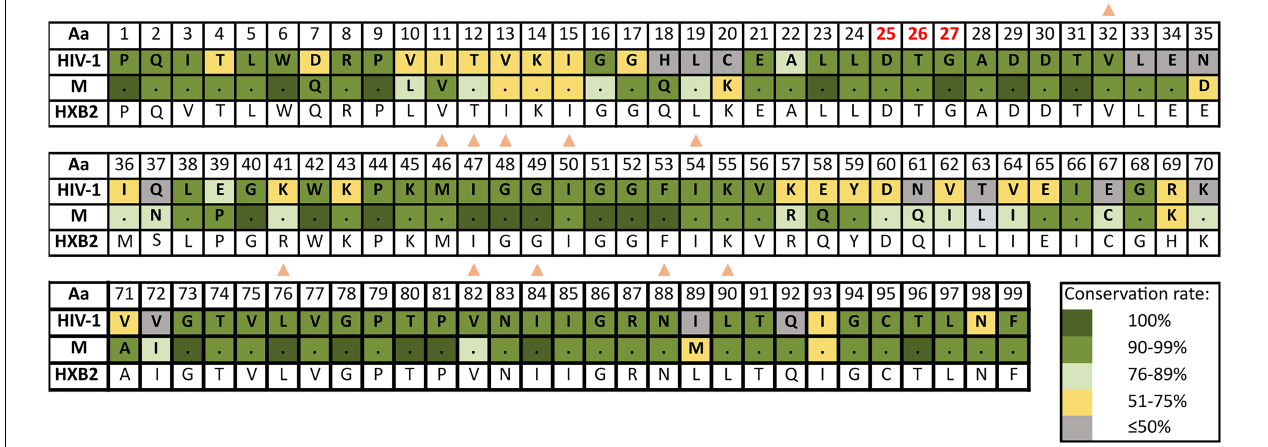
FIGURE 3 | Amino acid conservation rate along PR in HIV-1 and group M consensus. aa, amino acid; M, group M consensus. PR, protease (99 aa). Dots in group M represent the same aa as in HIV-1 consensus for that position. HXB2 reference sequence is described below the groups for further guidance. Colors represent the conservation rate. Residues of PR active site (triad Asp25-Thr26-Gly27, conserved among aspartyl proteases) are highlighted in red font. Orange triangles indicate positions where major DRM to PI are located according to Stanford v9.0 (Release Notes - HIV Drug Resistance Database, 2020) and summarized in https://cms.hivdb.org/prod/downloads/resistance-mutation-handout/resistance-mutation-handout.pdf. Aa code: A, alanine; C, cysteine; D, aspartic acid; E, glutamic acid; F, phenylalanine; G, glycine; H, histidine; I, isoleucine; K, lysine; L, leucine; M, methionine; N, asparagine; P, proline; Q, glutamine; R, arginine; S, serine; T, threonine; V, valine; W, tryptophan; Y, tyrosine.